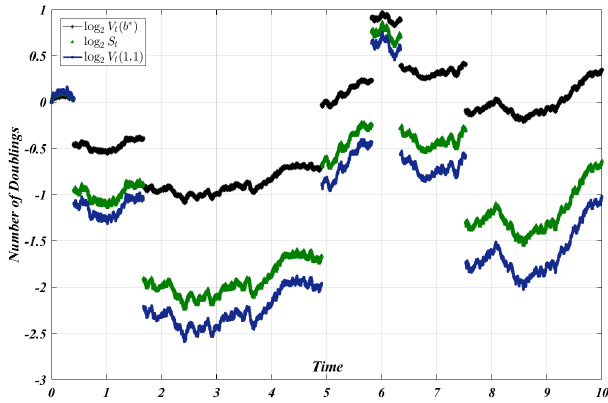
Figure 3. A (different) sample path in the small. ν : = 0.07, σ : = 0.15, r : = 0.03, λ : = 1, b : = 0.585, c : = 1, d : = 1.1, x ∈ { + 100%, − 50% } , T : = 10.